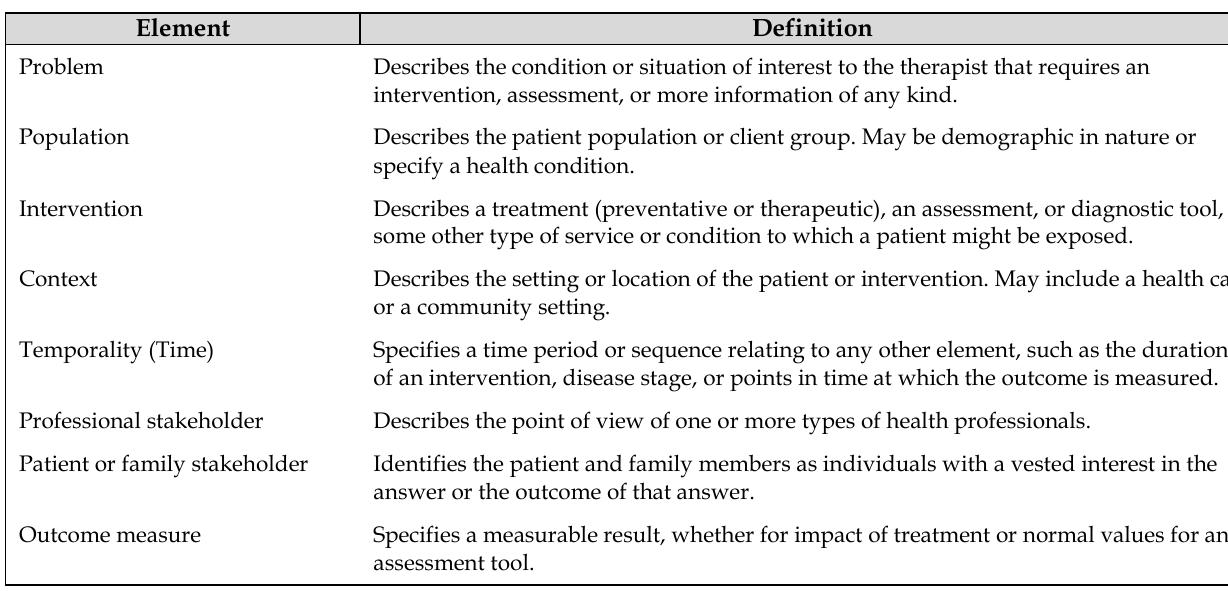
Table 1 Structural elements in clinical questions using the alternative framework